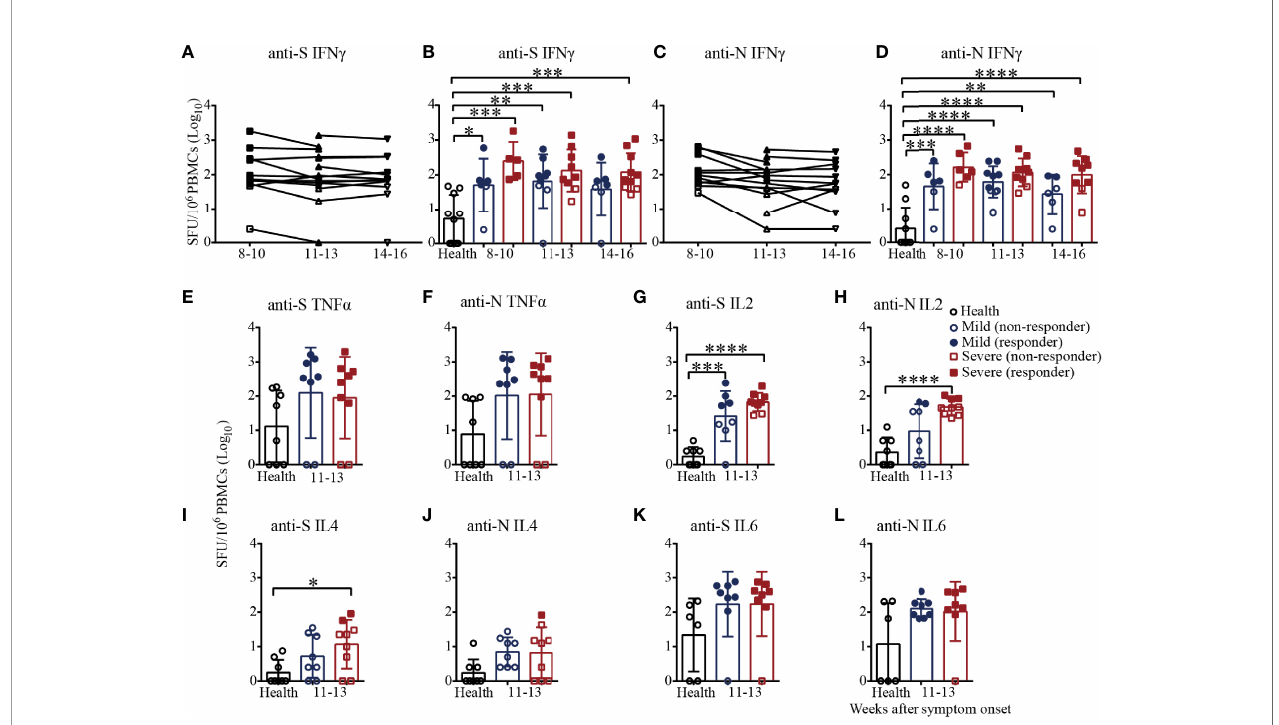
FIGURE 6 | T-cell responses to SARS-CoV-2 in recovered COVID-19 patients measured by ELISpot analysis. IFN g ELISpot analysis of responses against the S (A) or N (C) protein peptide pool in COVID-19 patients from 8 to 16 weeks after symptom onset. Comparison of the IFN g responses against the S (B) or N (D) protein peptide pool between mild and severe patients from 8 to 16 weeks after symptom onset. Comparison of the TNF a responses against the S (E) or N protein peptide pool (F) between mild and severe patients from 11 to 13 weeks. Comparison of the IL2 responses against the S (G) or N (H) protein peptide pool between mild and severe patients from 11 to 13 weeks. Comparison of the IL4 responses against the S (I) or N (J) protein peptide pool between mild and severe patients from 11 to 13 weeks. Comparison of the IL6 responses against the S (K) or N (L) protein peptide pool between mild and severe patients from 11 to 13 weeks (Health, n=10; patient, n=22). *P<0.05; **P<0.01; ***P<0.001;